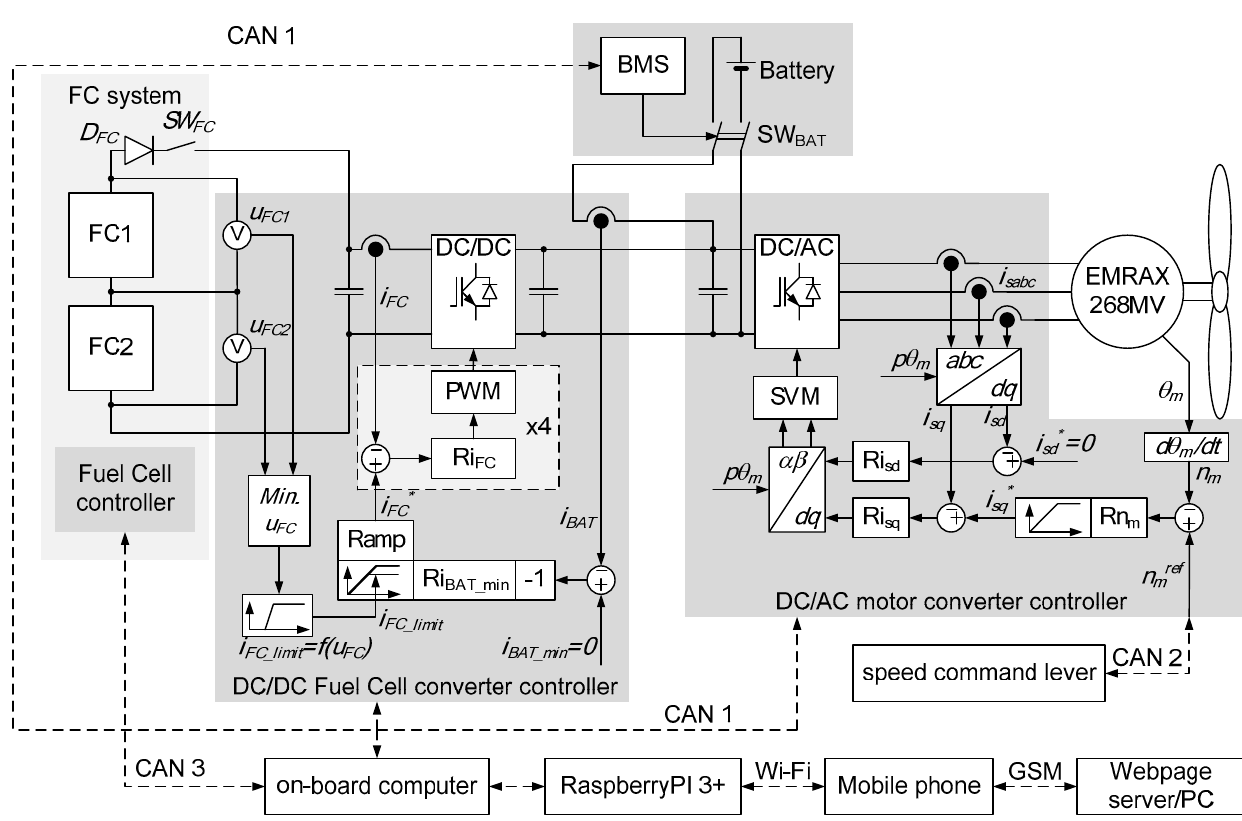
Figure 7. Detailed control and communication structure of the power conversion system in a hybrid fuel cell and battery-based electric drive for the AOS-H2 motor glider.